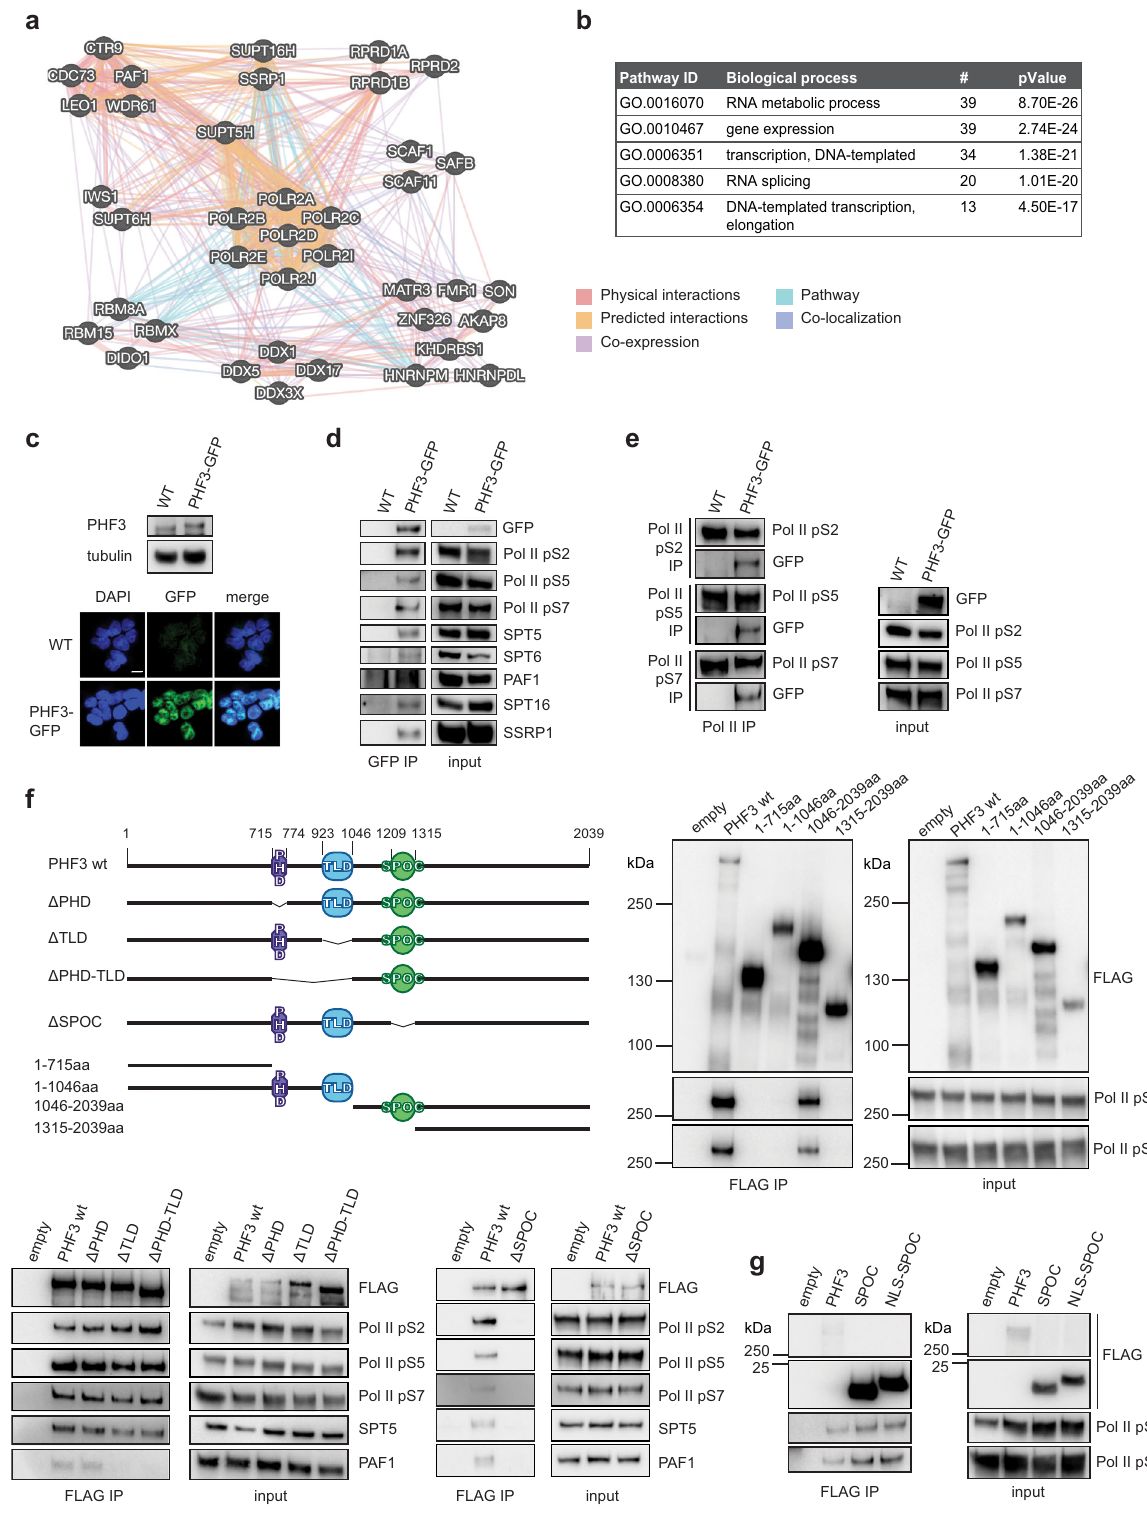
2xpS2-containing peptides with comparable binding af fi nities were used for structural analysis to determine whether PHF3 SPOC exclusively binds tandem pS2 marks or whether it can concomitantly engage pS7 or pS5 as shown for yeast Rtt103 (binds pS2pS7) and human PIN1 (binds pS2pS5) 44,45 . Super- imposition of PHF3 SPOC with SPOC domains from SHARP 38 and FPA 46 revealed that PHF3 SPOC has a distorted β -barrel